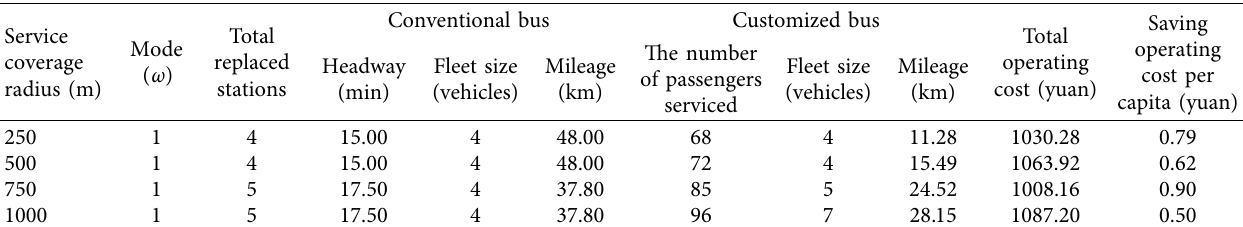
Table 6: The optimal bus operation plans with different travel demands in integrated operation mode II.